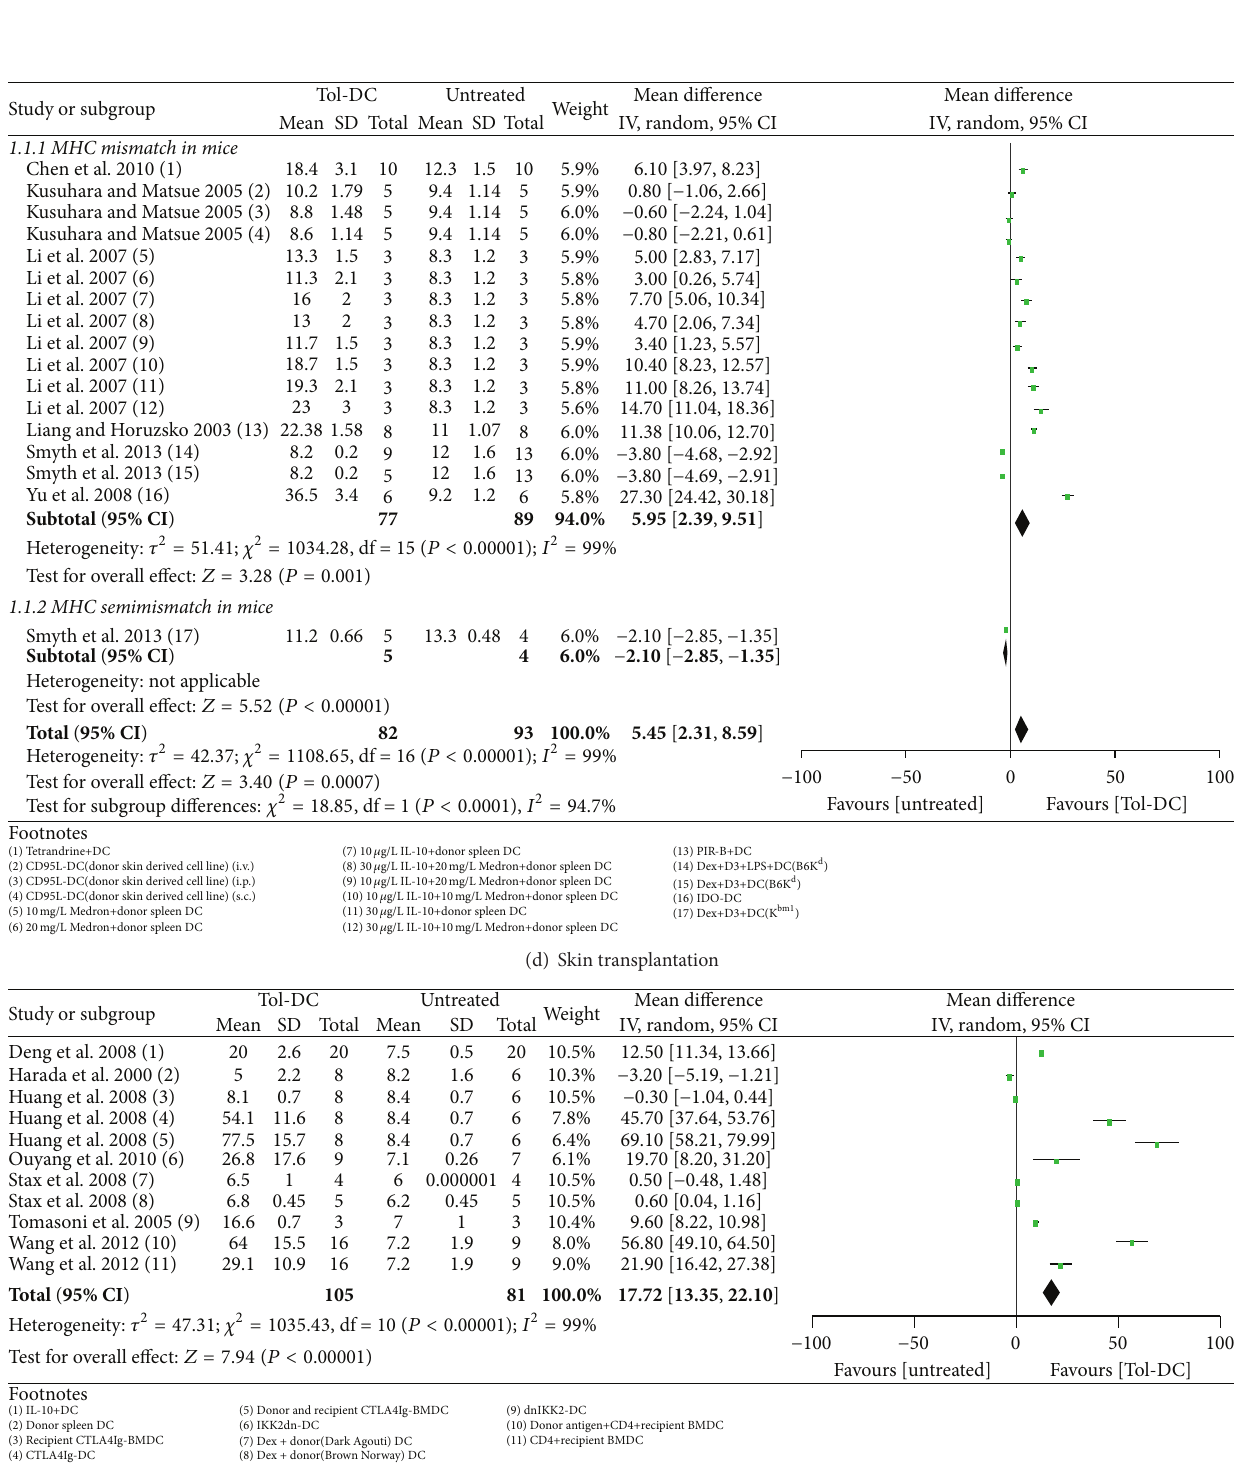
Figure 3: Mean difference (95% confidence intervals) for Tol-DC infusion versus untreated groups for allografts survival in islet (a), small intestine (b), liver (c), skin (d), and renal (e) transplantation models. Except for MHC semimismatch model in skin transplantation